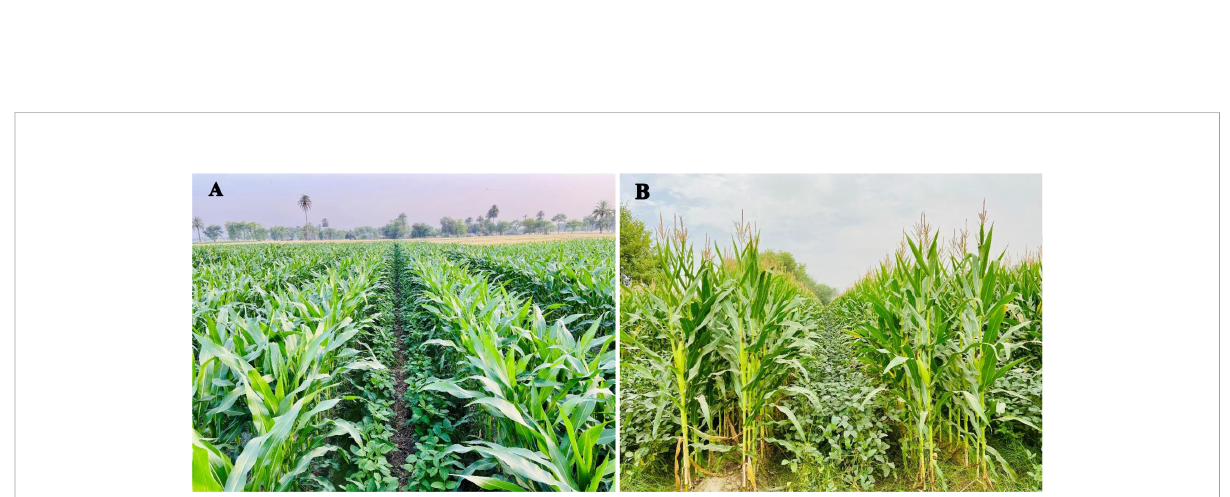
FIGURE 2 Field demonstration of maize/soybean strip intercropping system. (A) Intercrops were at the vegetative growth stage, and (B) Intercrops were at the reproductive growth stage (Photos: Muhammad Ali Raza). Location: Punjab Province, Pakistan.